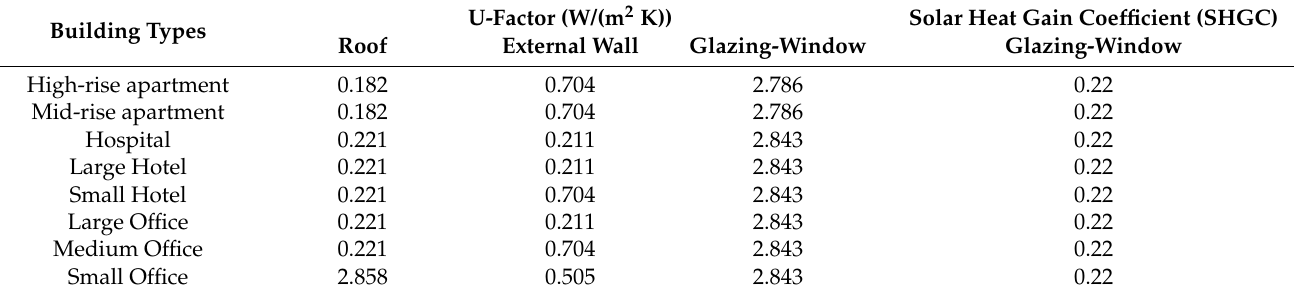
Table 3. Building envelope